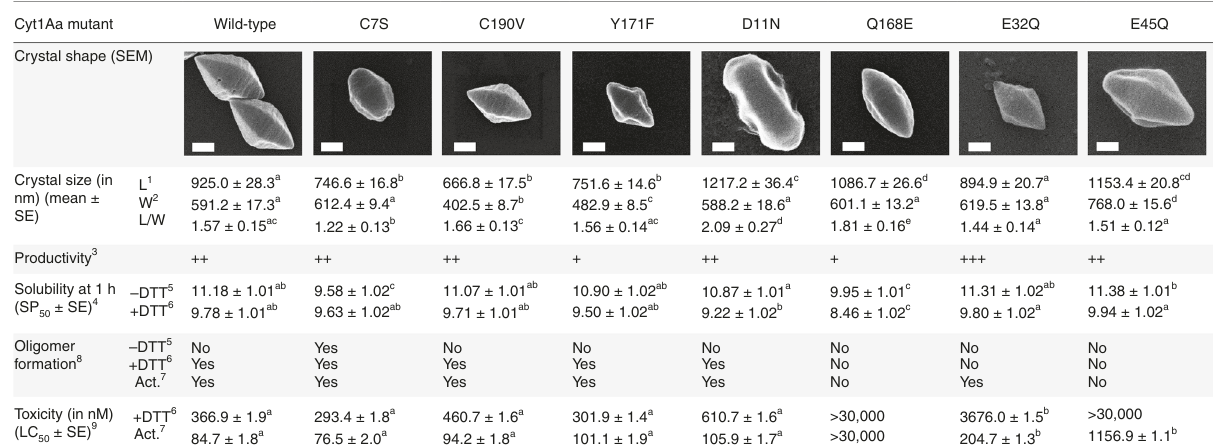
Fig. 3 Point mutations affect different steps along the Cyt1Aa bioactivation cascade. For each row, different letters indicate signi fi cant differences between mutants. 1 Length and 2 width of crystals. 3 Productivity was visually estimated based on the quantity and aspect of the crystal-spore suspension collected. 4 SP 50 corresponds to the concentration at which 50% of crystals solubilize after 1 h incubation at RT. See Supplementary Table 2 for corresponding statistics. 5 Protoxin solubilized without DTT, releasing a disul fi de-bridged dimer (except for C7S), and 6 with DTT, releasing a protoxin monomer. 7 Toxin monomer activated by proteinase K. 8 Capacity of each toxin species to generate a ladder pattern characteristic of membrane-bound oligomers (MBO) on 6% SDS-PAGE. See corresponding gels in Supplementary Fig. 9. 9 LC 50 corresponds to the concentration lethal for 50% of cell population. See Supplementary Table 2 for corresponding statistics. Scale bar = 0.2 µ m. Source data are provided as a Source Data fi